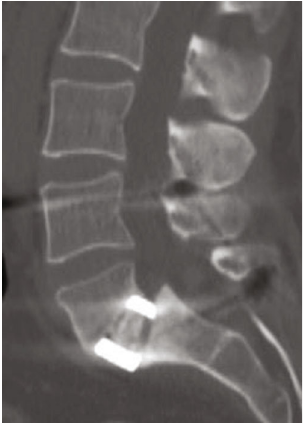
Figure 4: One-year CT scan control, highlighting the correct fusion of the L5-S1